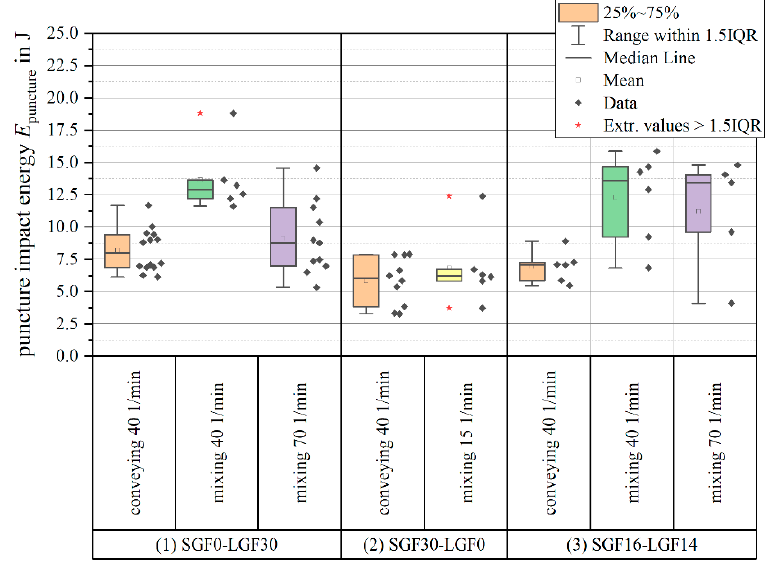
Figure 12. Puncture impact energy of 30 wt.-% specimens (usage and extension of the results presented in [57,58]).